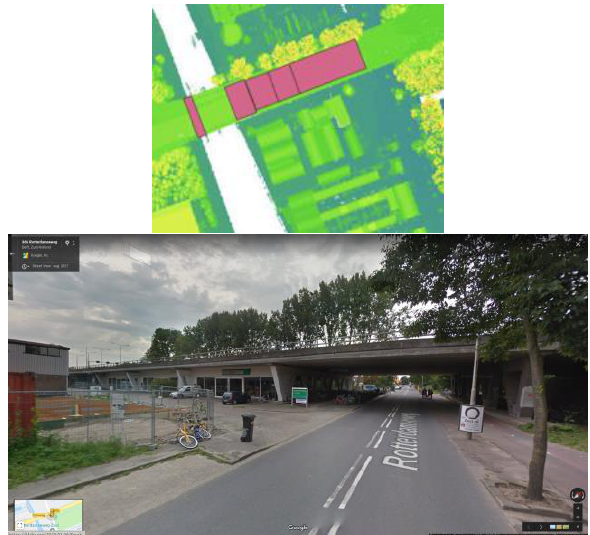
Figure 5. Buildings under bridges have no corresponding heights in AHN. Picture from ©